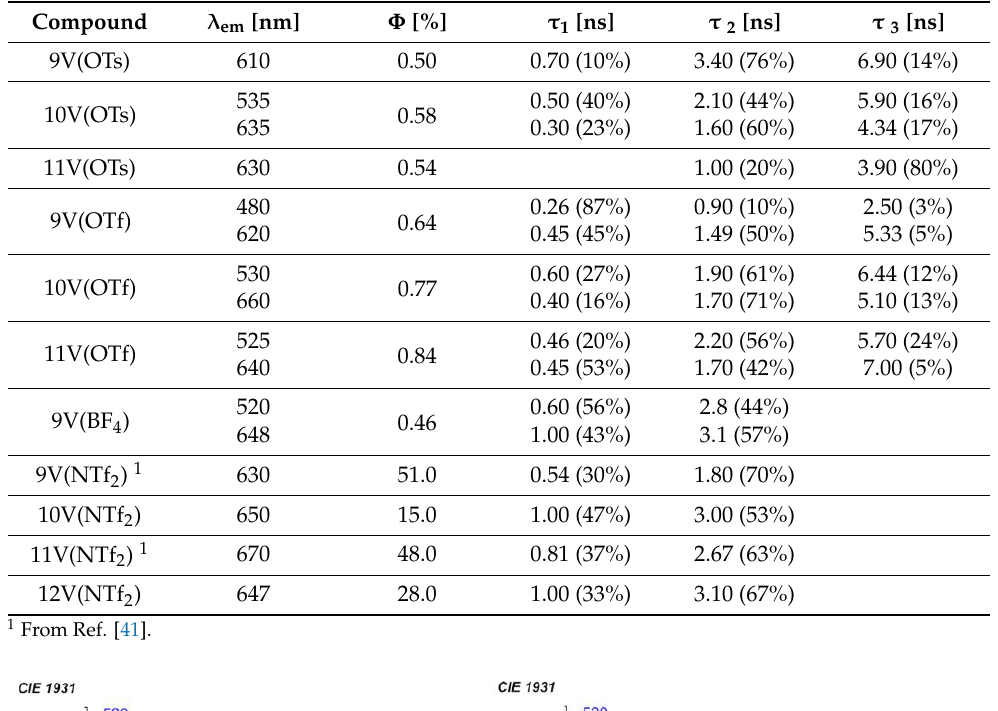
Table 2. Photophysical properties of the thienoviologens in bulk state at room temperature.